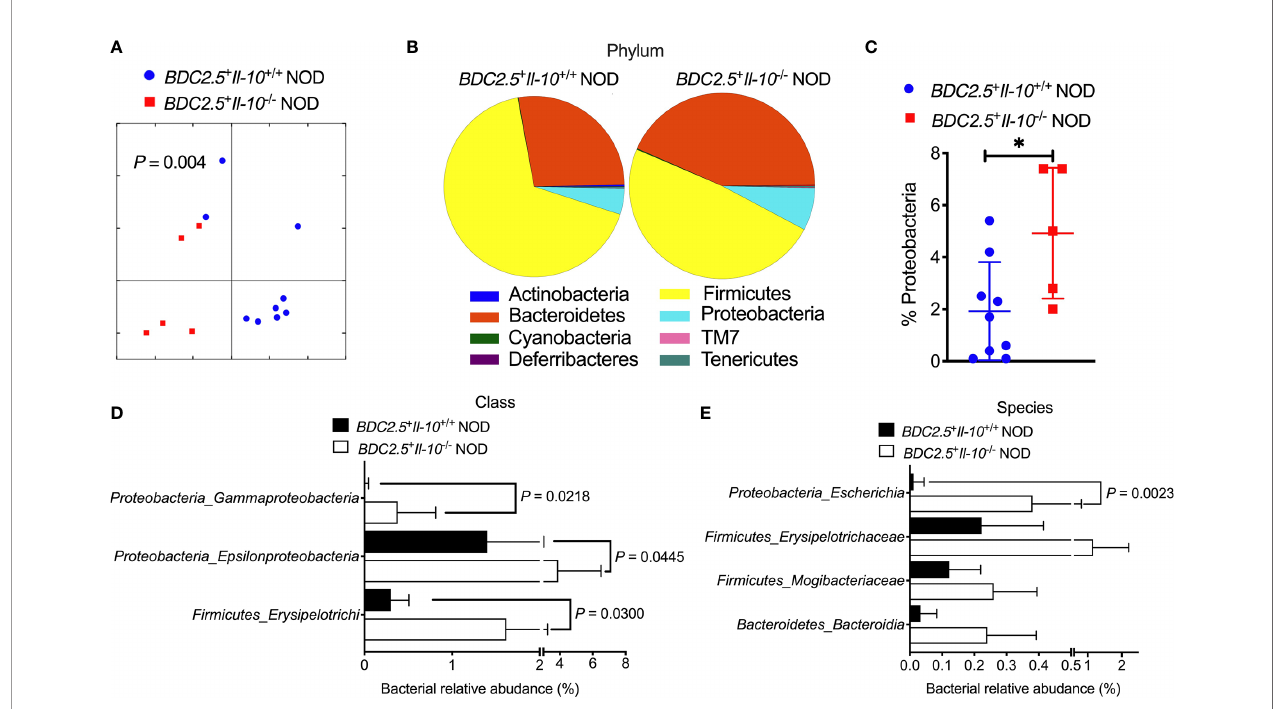
FIGURE 4 | Gut bacterial composition of BDC2.5 + Il-10 -/- NOD mice showed distinct differences compared with BDC2.5 + Il-10 -/- NOD mice. Gut bacteria in fecal pellets were analyzed by 16S rRNA sequencing ( n = 5-9/group). (A) b -diversity of the gut bacteria indicated by unweighted PCoA. (B, C) Gut bacterial composition at the phylum level including representative composition (B) and summarized percentage of Proteobacteria as an example (C) . (D) Gut bacterial composition at the class level. (E) Gut bacterial composition at the species level. Statistical analysis was performed by an analysis of similarities (ANOSIM) (A) , a two-tailed Student ’ s t -test (C) , or multiple t -tests with Bonferroni correction (D, E) . P < 0.05 was considered statistically signi fi cant. * P =